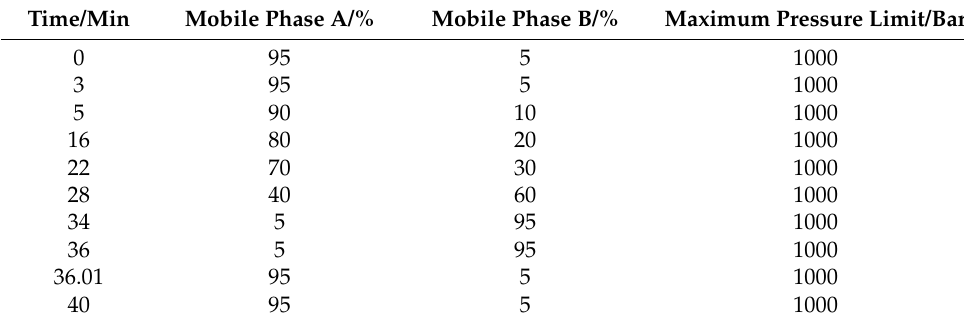
Table 1. Mobile phase